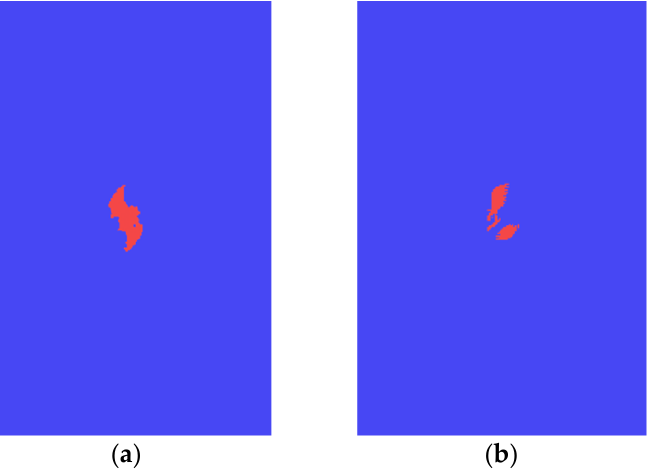
Figure 11. Comparison of the matrix damage. ( a ) Damage with 3D Hashin criterion. ( b ) Damage with 2D Hashin criterion.